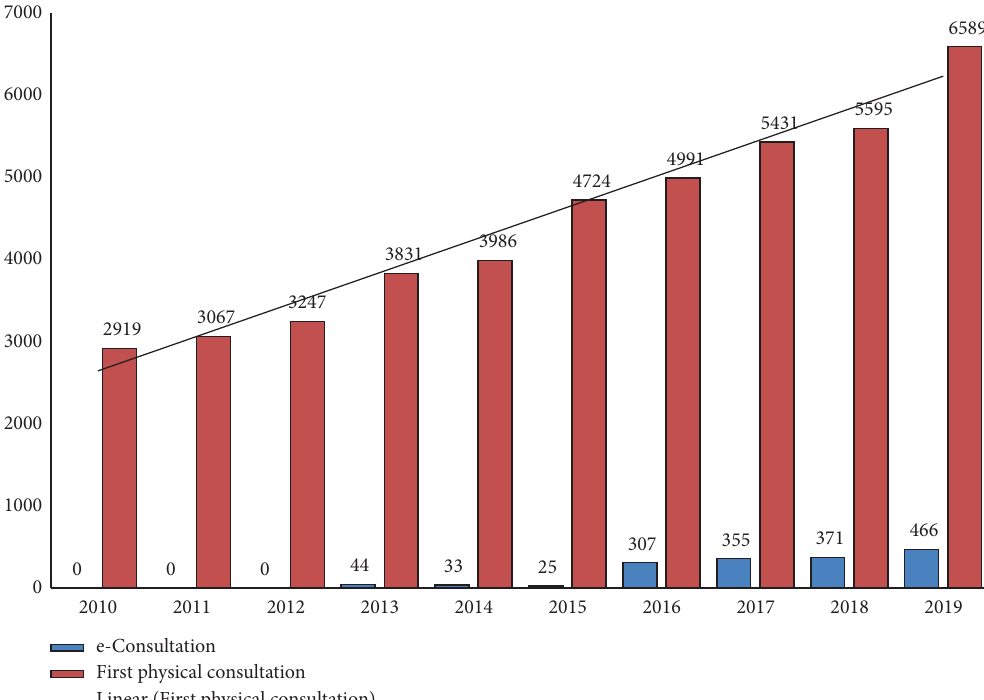
Figure 2: Evolution of requests for e-consultations and frst face-to-face consultations to pulmonology (years 2010–2019). Legend of fgure: columns in maroon correspond to face-to-face